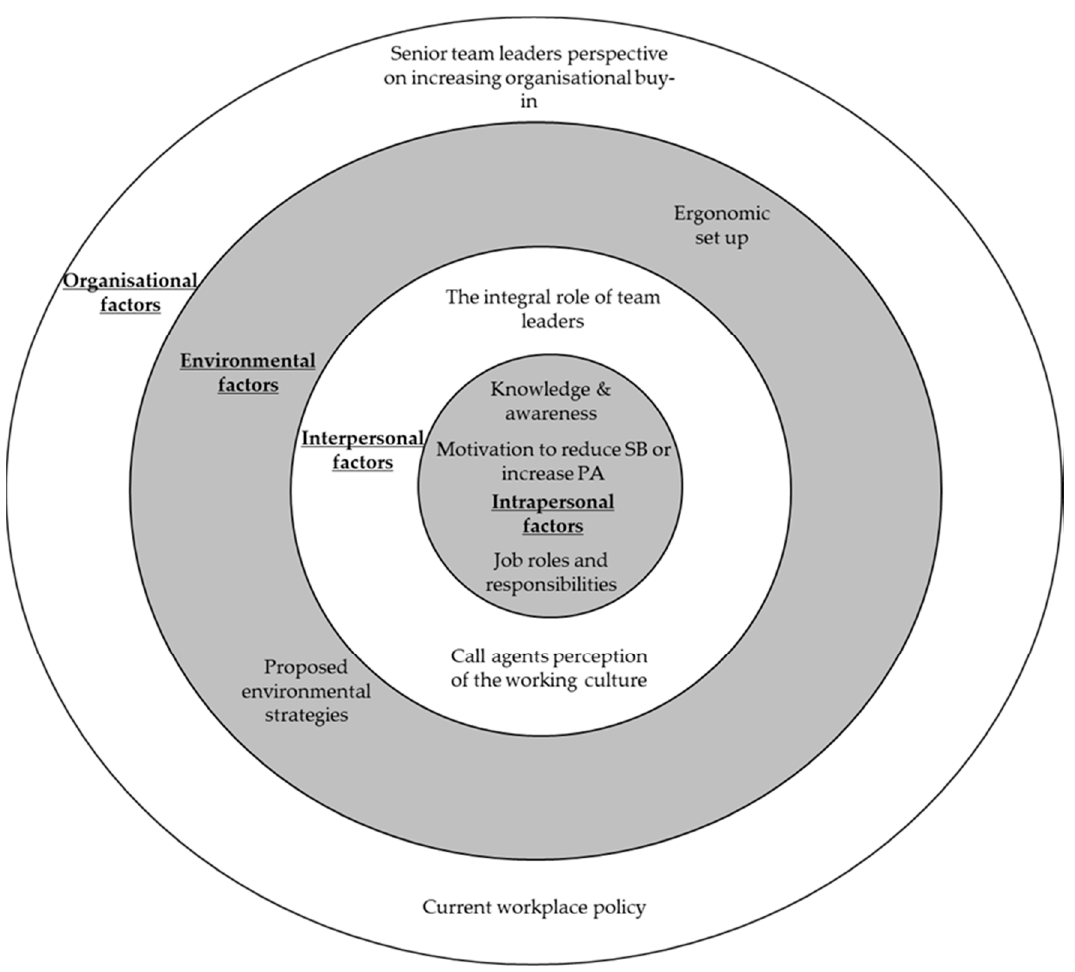
Figure 1. An overview of the higher-order themes that represent factors influencing call agents’ workplace PA and SB across four levels of the